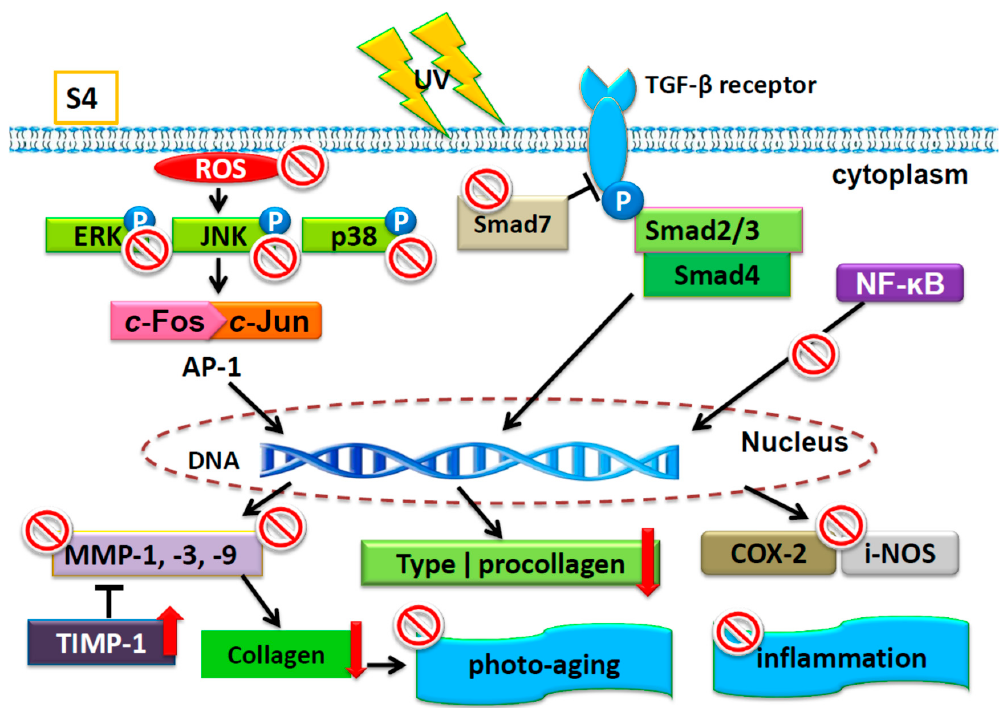
Figure 16. Schematic diagram of S4 ameliorated UVB-induced skin damage.